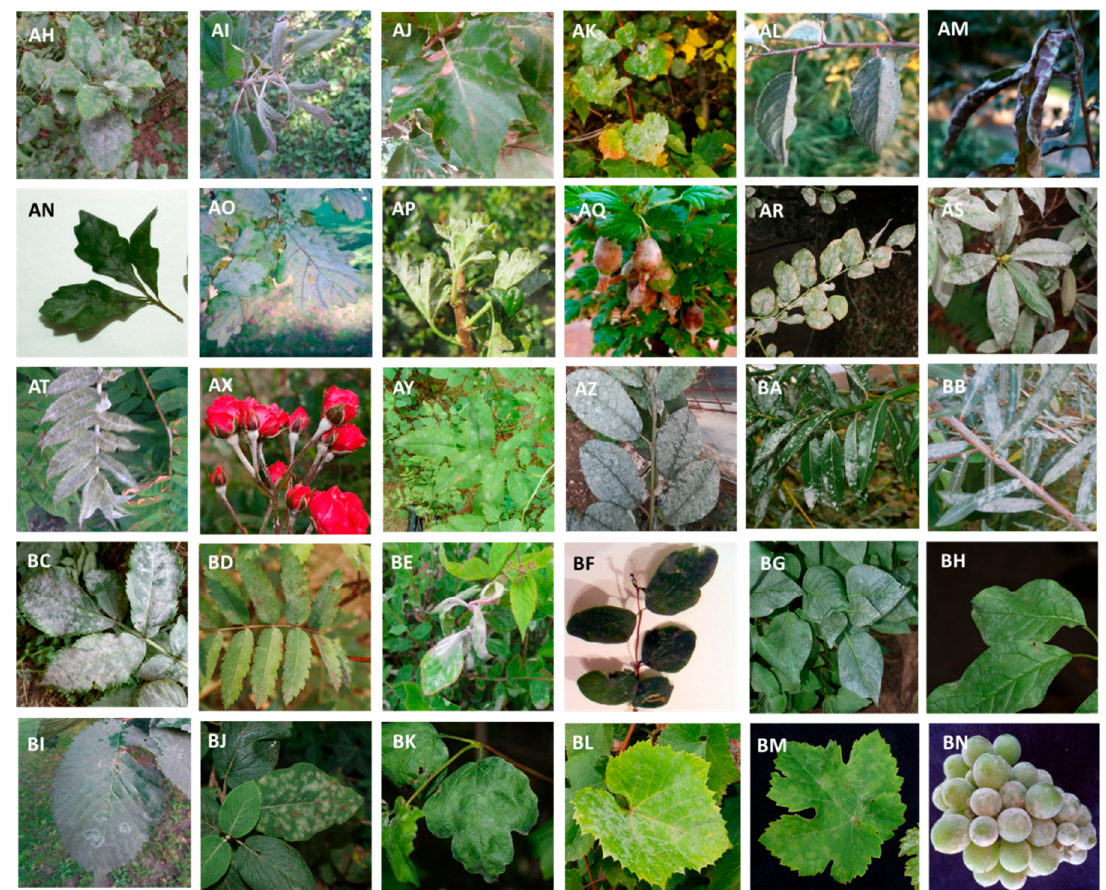
Figure 2. Symptoms of powdery mildew infection on hosts examined in our survey cross-referenced to lists of hosts and powdery mildews in Table 1: A — Acer campestre L. (MM), B — Acer negundo L. (BM),